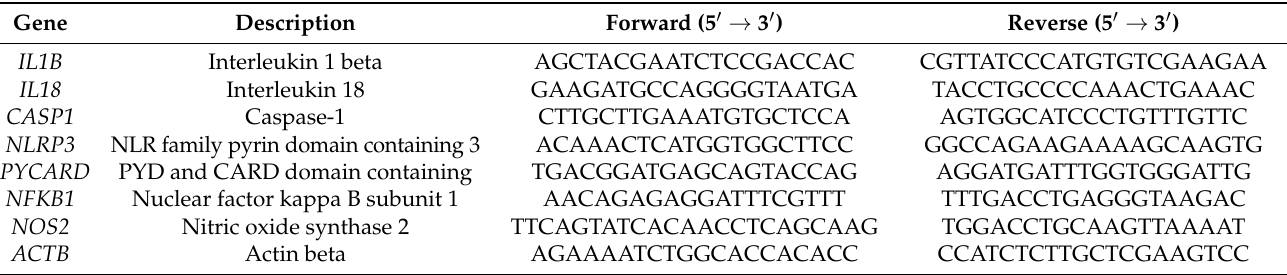
Table 1. Primer sequences used in this